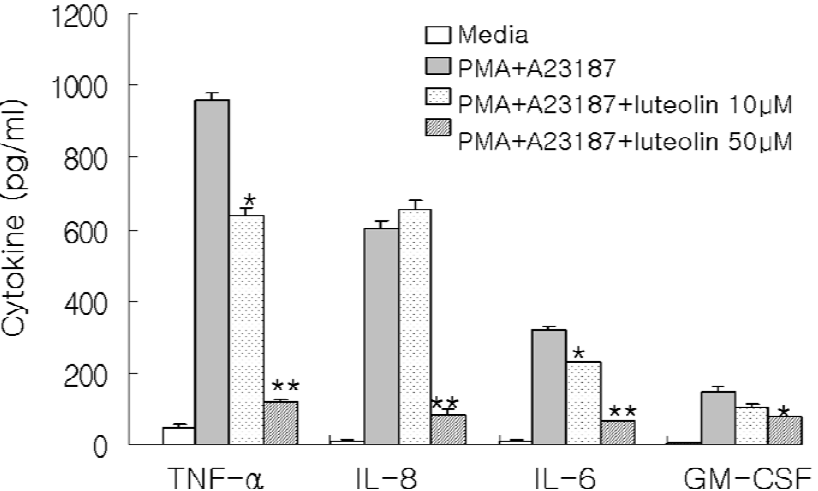
Figure 1. Effect of luteolin on production of pro-inflammatory cytokines in PMA plus A23187-induced HMC-1 cells.